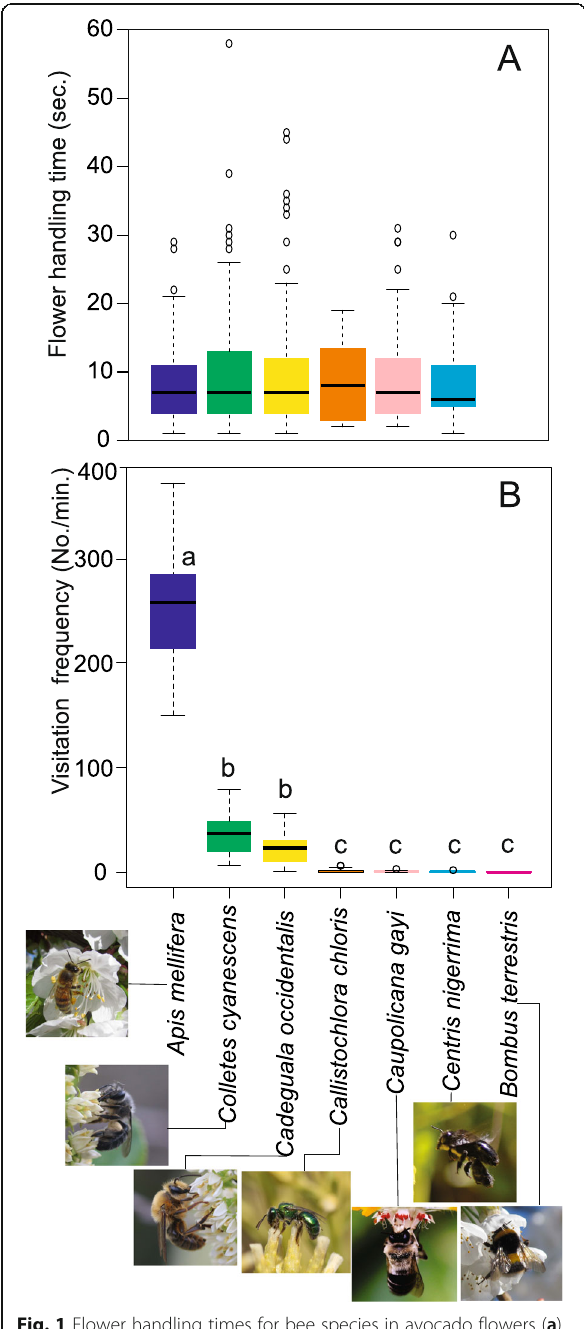
Fig. 1 Flower handling times for bee species in avocado flowers ( a ) and their respective frequencies ( b ), Hijuelas orchard, Valparaíso Region, Chile. Boxplots represent means and lines the 95% confidence interval. Statistical analyses: ( a ) χ 2 = 6.40, d.f. = 5; p = 0.27 and ( b ) χ 2 = 502.38, d.f. = 7; p ≤ 0.001 (GLMM,